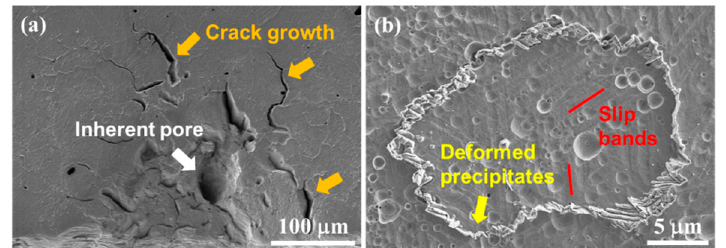
Figure 6. The polished fracture surface of the 1177-AC specimen. ( a ) The crack near an inherent pore. ( b ) The precipitated phases on the grain boundaries can act as a barrier for dislocation motion.